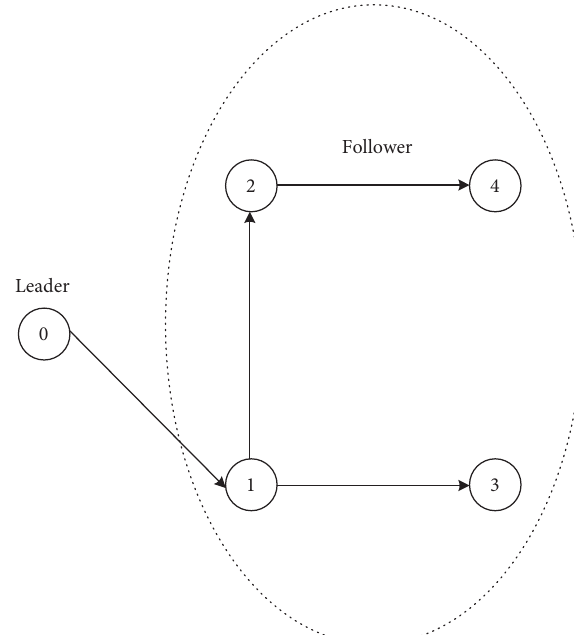
Figure 2: The network topology for the discrete-time